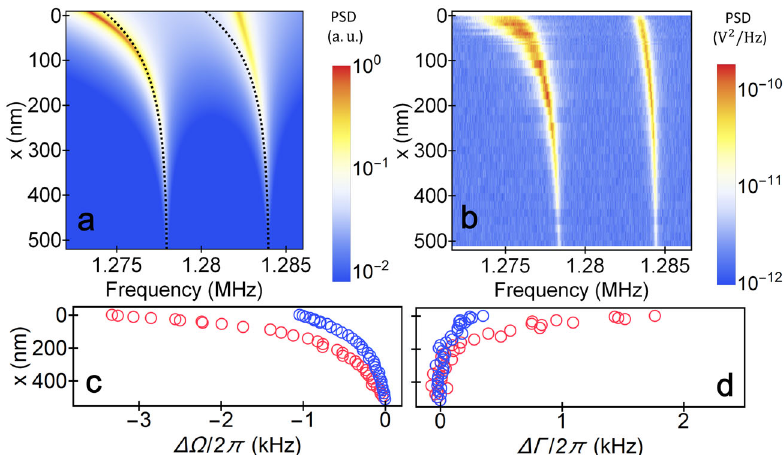
Fig. 4 Two-mode mechanical responses with static optical forces. a Theoretically predicted two-mode power spectral density (PSD) with optical force fi eld in terms of gap x . The black dashed lines show the two-mode frequencies without rotation of eigen-modes. b Experimentally observed two-mode power spectral density with respect to x coordinate. c , d Mechanical frequencies and linewidths with respect to x coordinate. The red and blue circles correspond to them in mode 1 (lower-frequency mode) and mode 2 (higher-frequency mode),